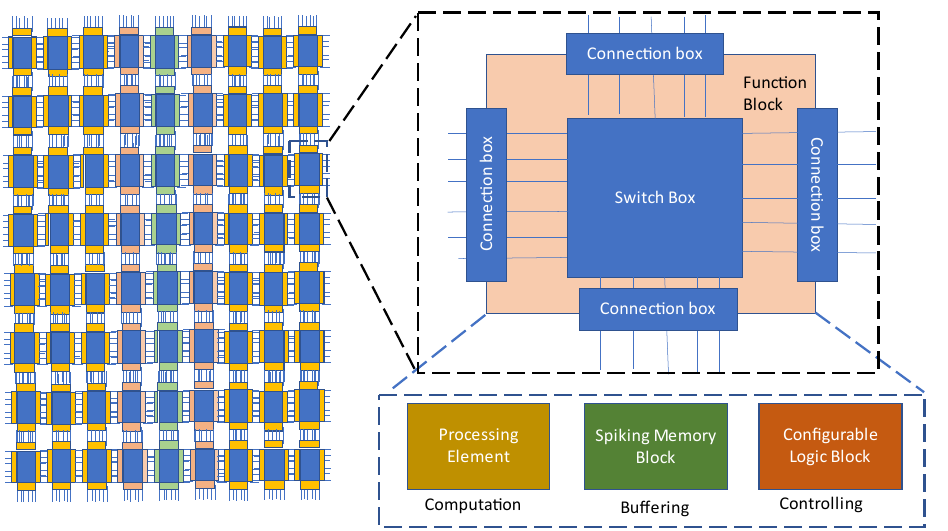
Figure 23. Overview of the FPSA architecture and reconfigurable wiring network [25].